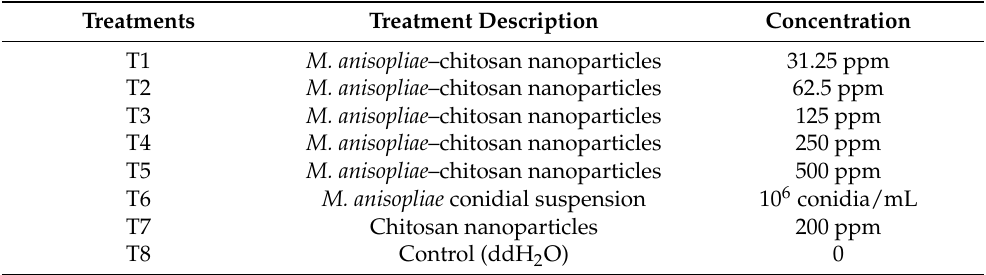
Table 1. Details of different M. anisopliae –chitosan nanoparticles and M. anisopliae treatments used in the bio-activity studies.